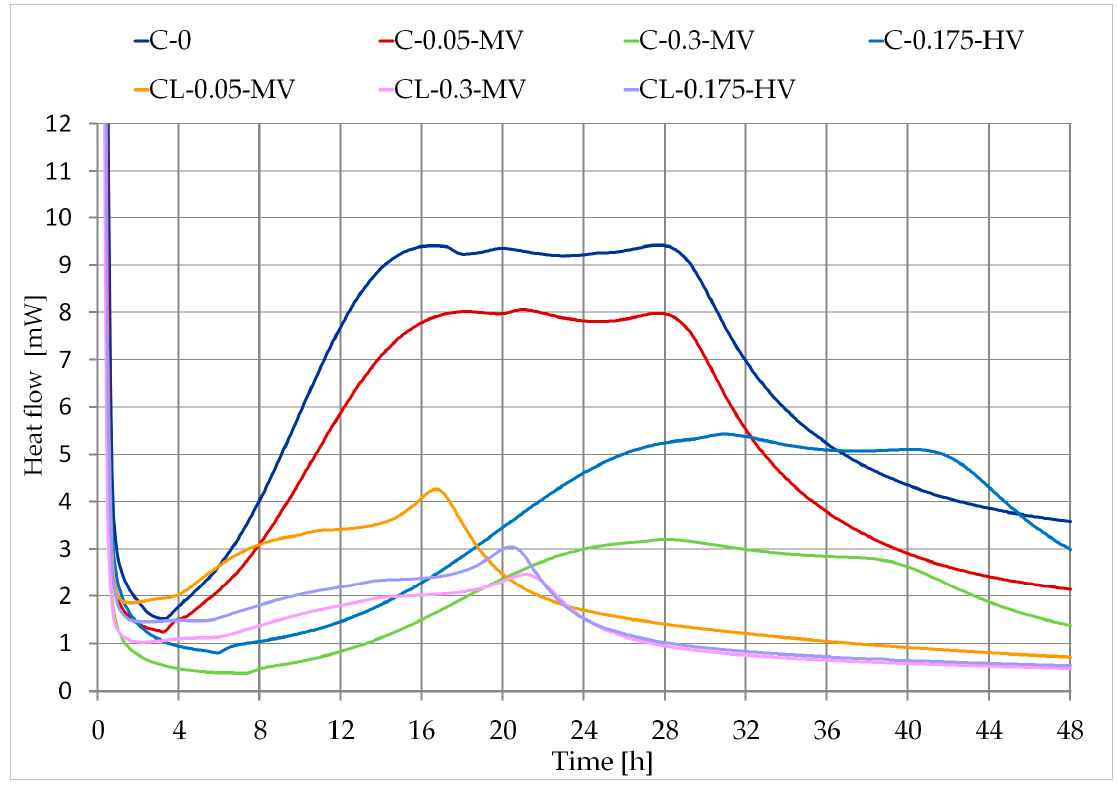
Figure 3. Isothermal calorimetry curves of all pastes (according to Table 3).